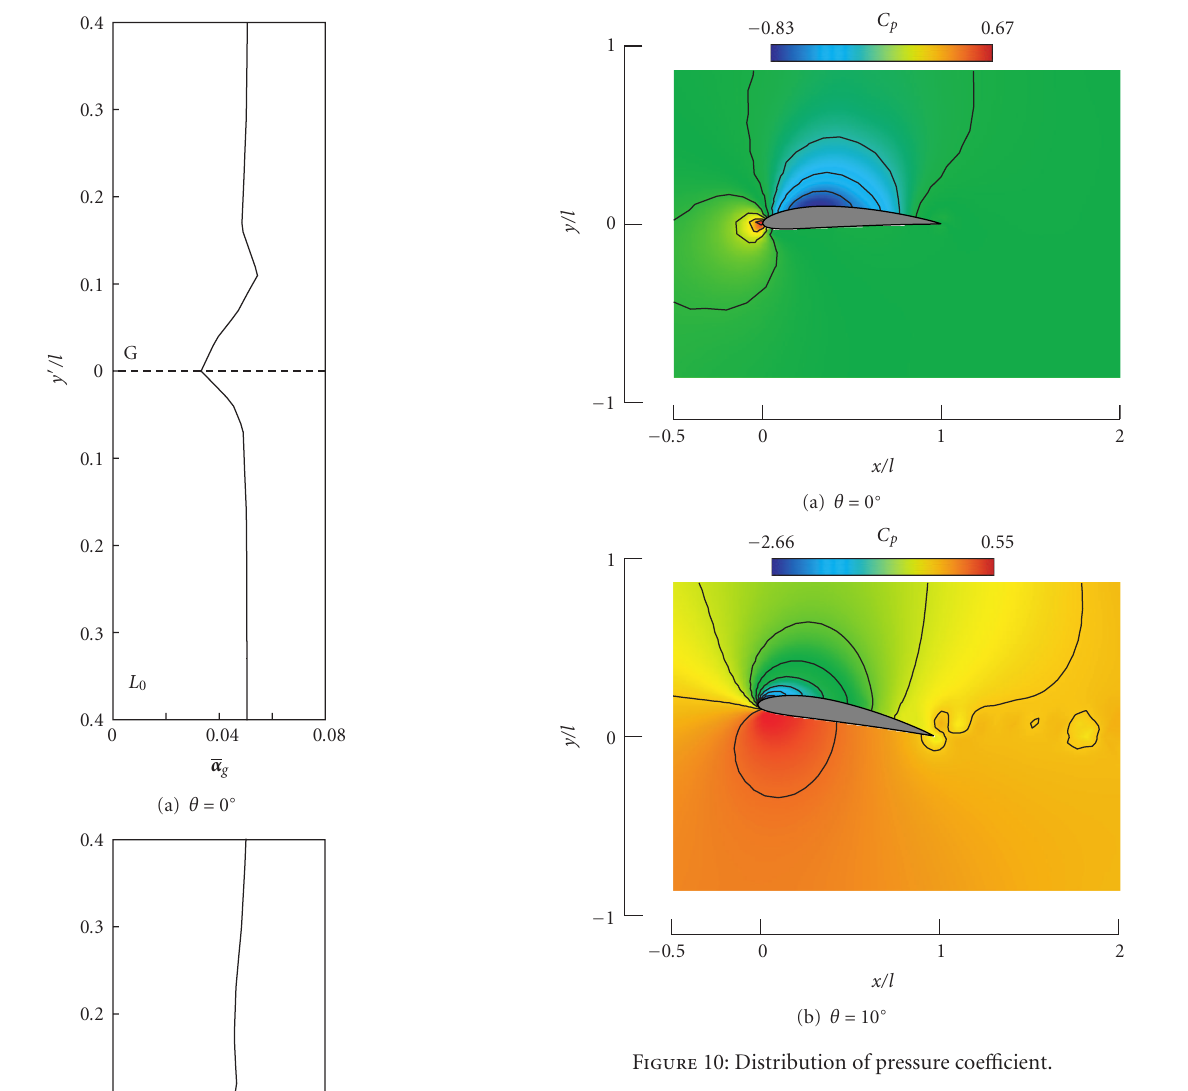
hydrofoil surface and causes the bubble accumulation there, accordingly α g heightens as found in Figure 6(a). The bub- ble accumulation does not occur near the lower-surface, be- cause the pressure remains unaltered in the flow direction. Figure 10(b) shows the result at θ = 10 ◦ . The pressure is lo- cally high near the leading edge of the lower-surface. As the pressure gradient prevents the bubble from approaching the hydrofoil surface, it causes the marked decrement in α g near the lower-surface as shown in Figures 6 and 8. The time-averaged value for C p , C p distributes on the hy- drofoil surface as shown in Figure 11. On the lower-surface, the distribution for the two-phase flow ( α g 0 = 0.048) is al- most the same as that for the single-phase flow ( α g 0 = 0). This is because the air volume fraction is lower near the lower- surface, as found from Figure 6. On the upper-surface, how- ever, the absolute value | C p | decreases at the two-phase flow condition. According to the experiment at Re = 4 × 10 5 [7], | C | on the upper-surface reduces with an increment in α p Therefore, the present simulation seems to be